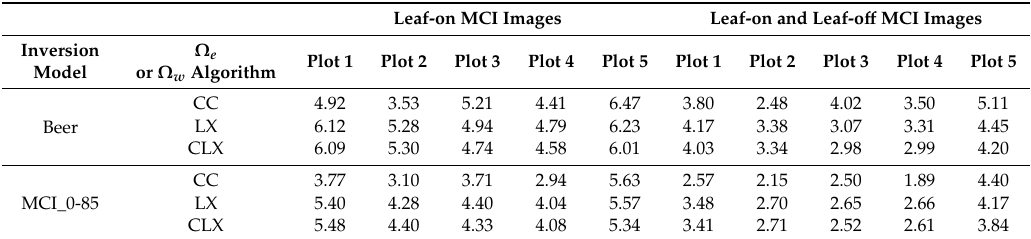
Table 6. LAI derived using the three canopy element or woody components clumping index ( Ω e or Ω w ) algorithms and inversion models from the leaf-on MCI images or both the leaf-on and leaf-o images in the five plots. When only the leaf-on MCI images were used in the LAI estimation, the WAIs of the five plots were obtained using Equations (8) and (11) based on the leaf-on MCI images. When both the leaf-on and leaf-o ff MCI images were used in the LAI estimation, the WAIs of the five plots were obtained using Equations (8) and (11) based on the leaf-o ff MCI images. Then, the LAI of the five plots was derived using Equation (16) based on the PAI and WAI measurements.